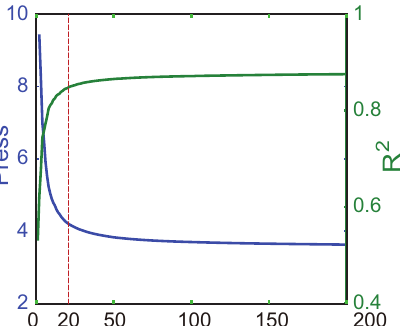
Figure 3. Predictive error sum of squares in model training for monkey B. The blue line and green line show predictive error sum of squares (PRESS) and R 2 values, respectively, for different numbers of latent variables used in the PLS model. The optimal number of 20 is denoted with the red dotted line.